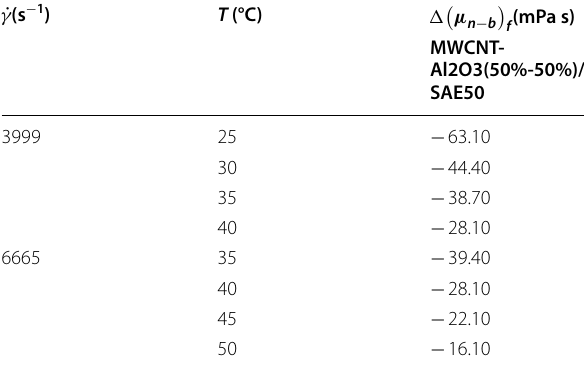
Table 7 A comparative study of the effect of temperature on the viscosity relative to the base